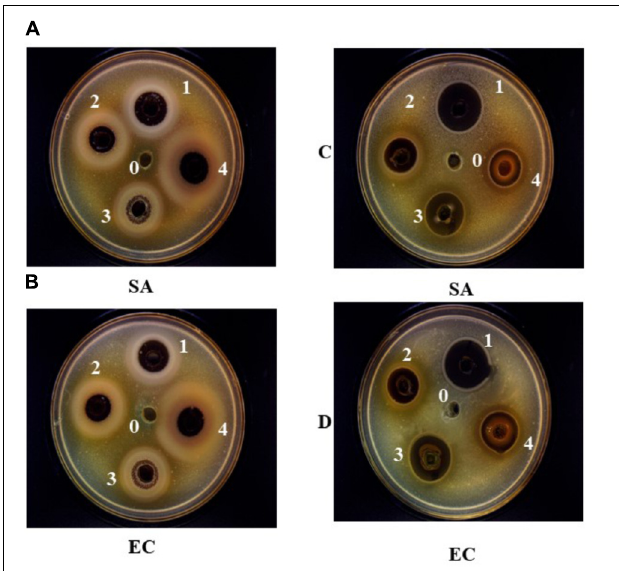
Table 1 summarized the extraction yield of each tested